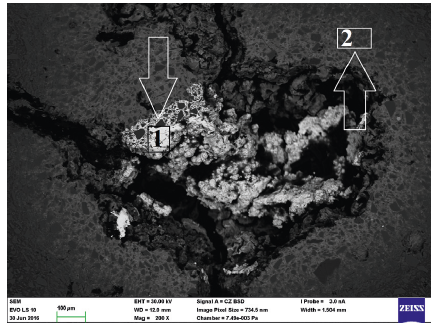
Figure 3: The microstructure of S2